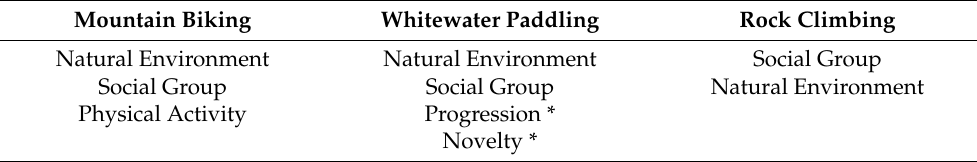
Table 6. Primary reasons for participating by